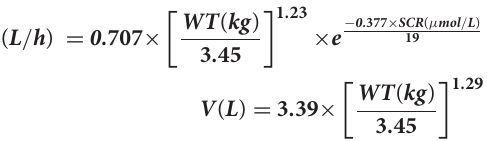
Model 3: The PPK model of vancomycin for the whole population with all levels of renal